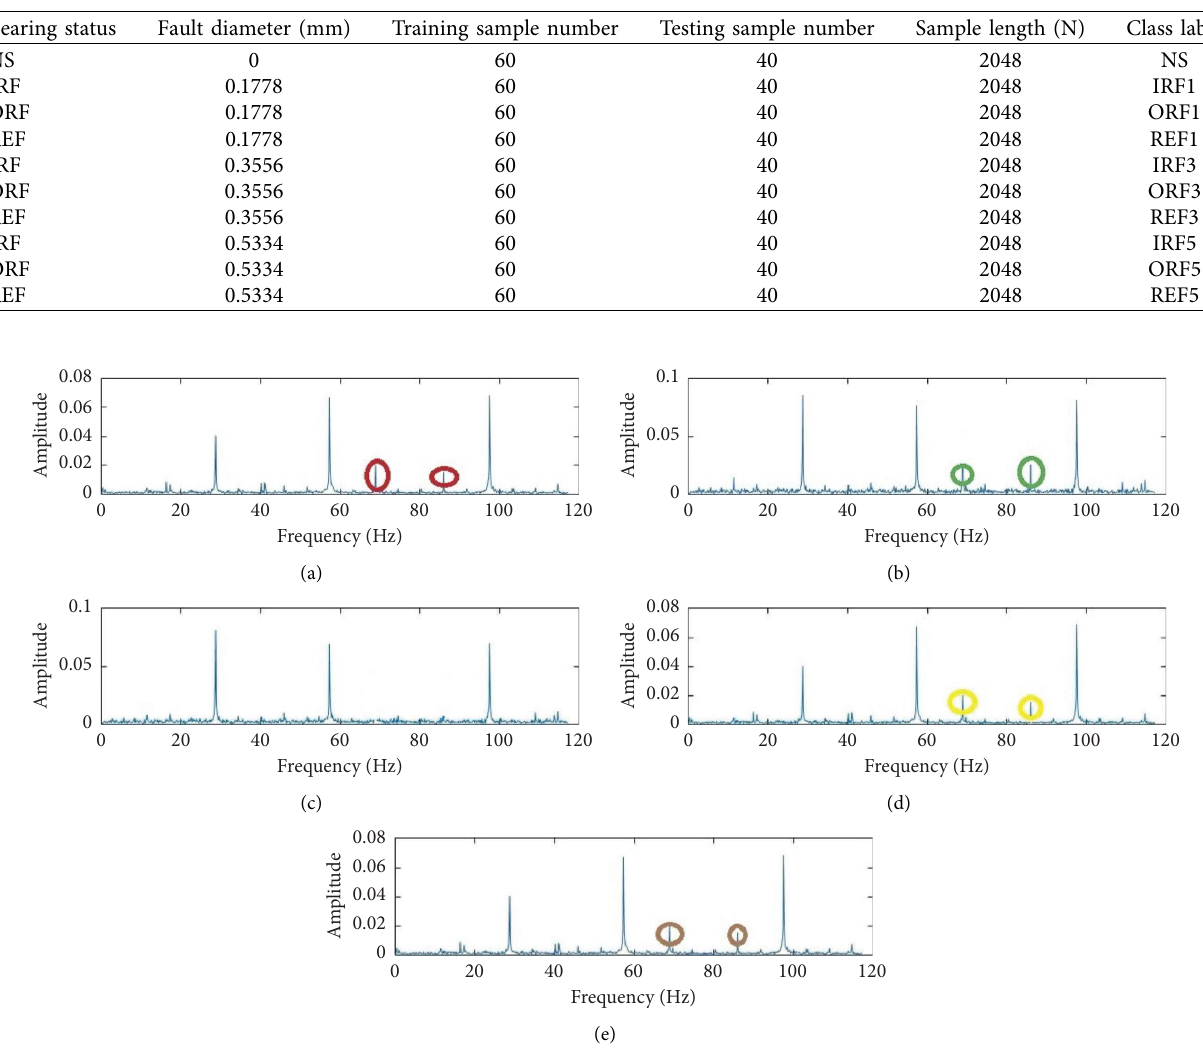
Table 1: Sample dataset.